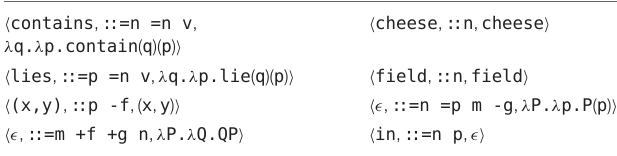
TABLE 5 | Minimalist